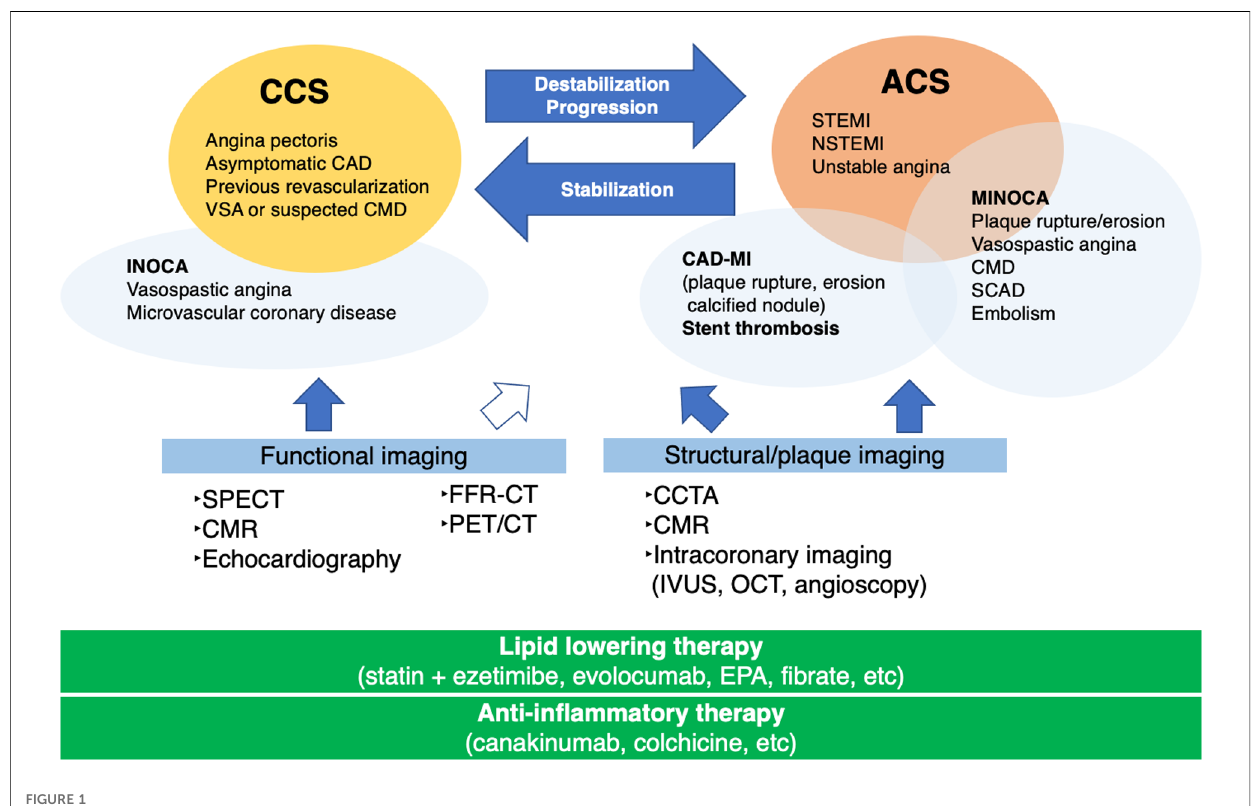
FIGURE 1 Role of imaging in the management of patients with coronary artery